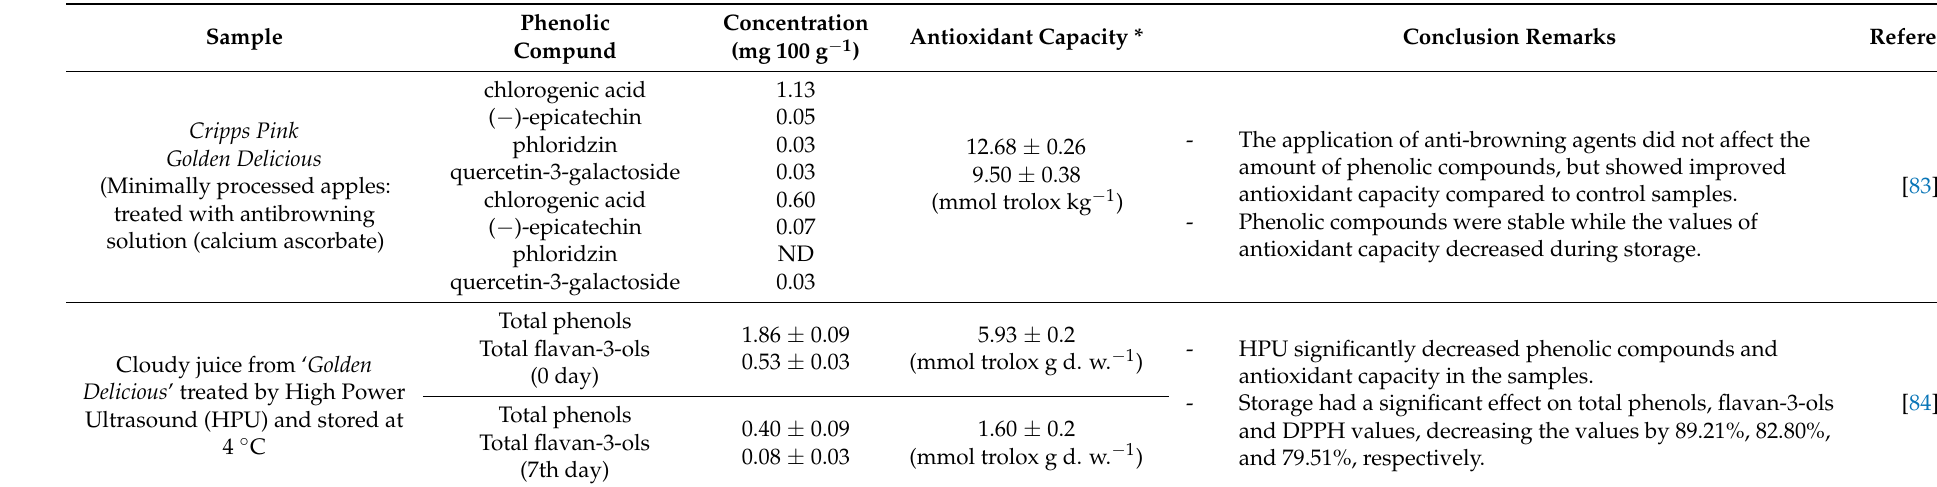
HPU significantly decreased phenolic compounds and antioxidant capacity in the samples. - Storage had a significant effect on total phenols, flavan-3-ols and DPPH values, decreasing the values by 89.21%, 82.80%, and 79.51%,